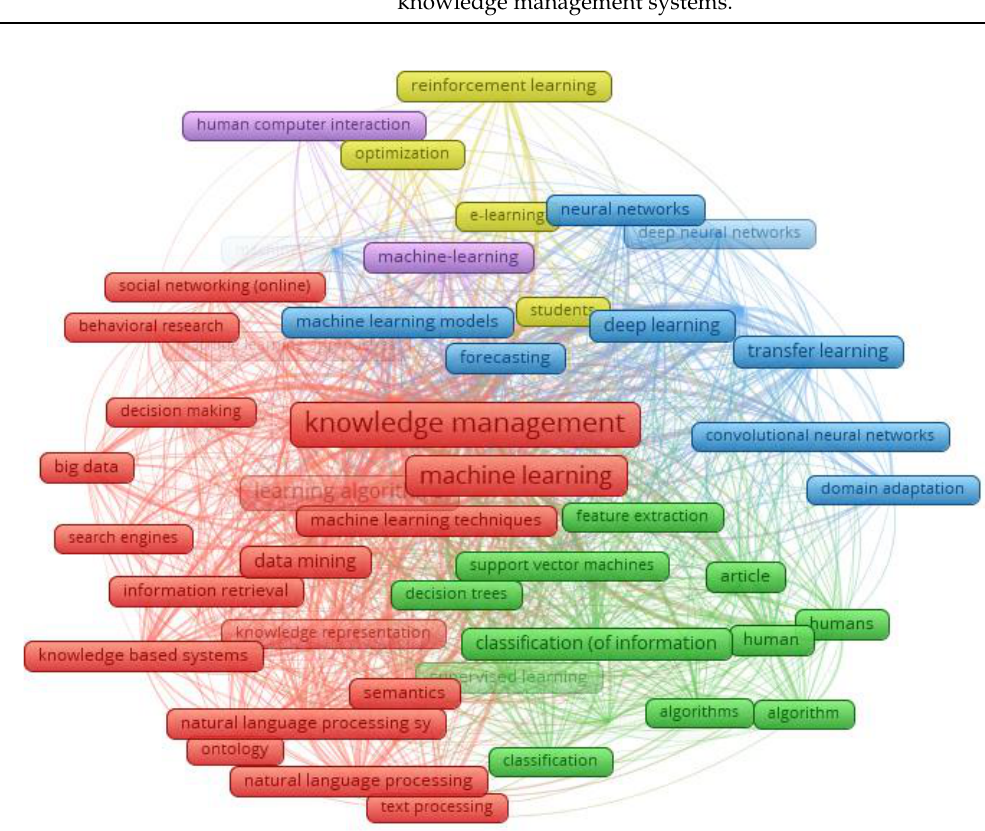
Figure 1. Network visualization for “machine learning” AND “knowledge management” .